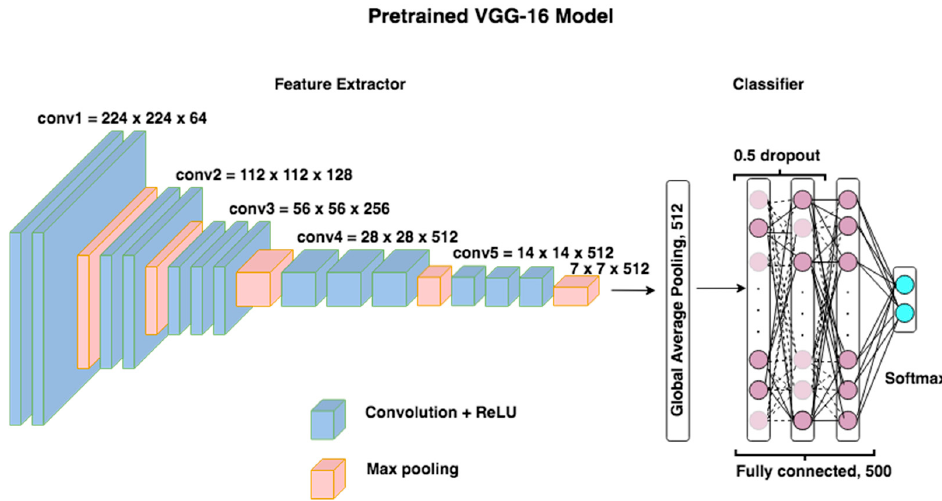
Figure 4. VGG-16 architecture.